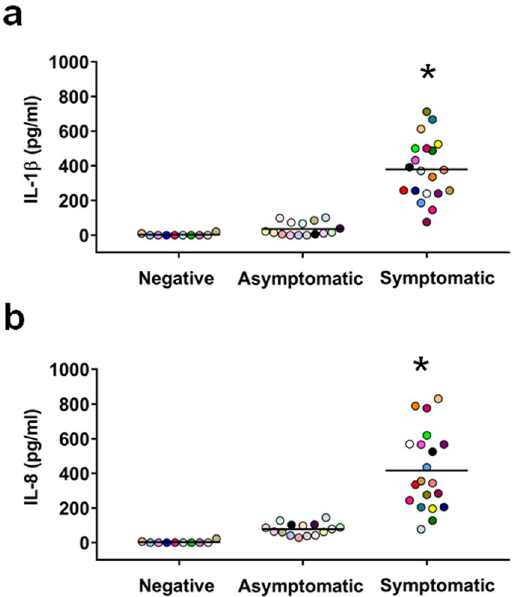
Figure 2. IL-1 β and IL-8 production in vaginal samples. The supernatants of vaginal samples of negative (n = 10, identified by dots with different colors), asymptomatic (n = 15, identified by dots with different colors) and symptomatic (n = 20, identified by dots with different colors) women were tested for IL-1 β ( a ) and IL-8 ( b ) production by specific ELISA assays. The results are from triplicates samples of each subjects and the statistical significance was determined with Mann Whitney U test. * p = 2.1 × 10 − 9 symptomatic vs asymptomatic women for IL-1 β . * p = 4.2 × 10 − 8 symptomatic vs asymptomatic women for IL-8.